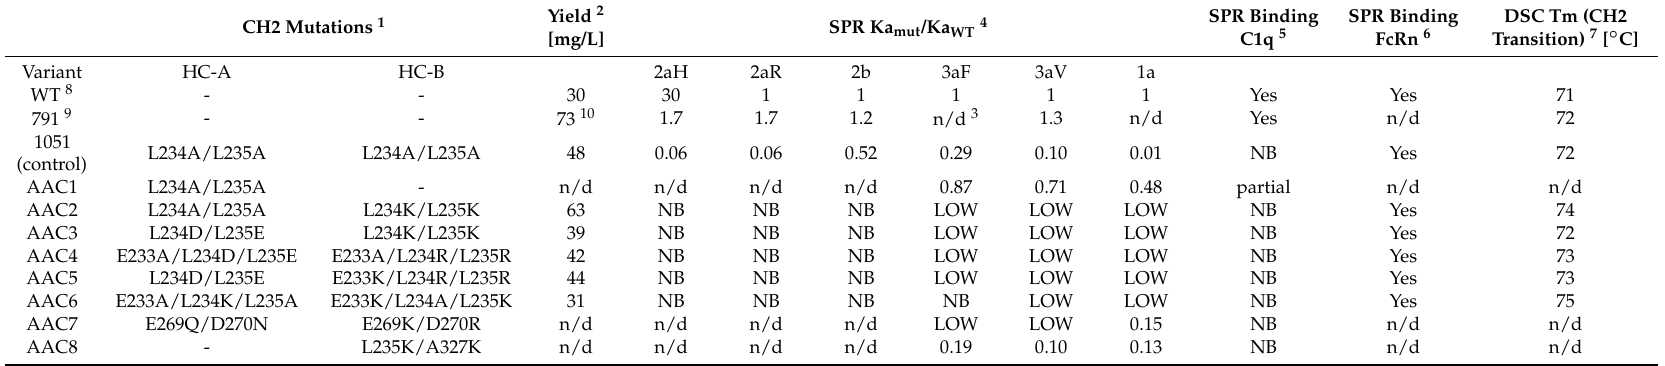
Table 1. CH2 mutations, transient expression yield, Fc γ R/C1q/FcRn binding and thermal stability of Asymmetric Antibody Constructs